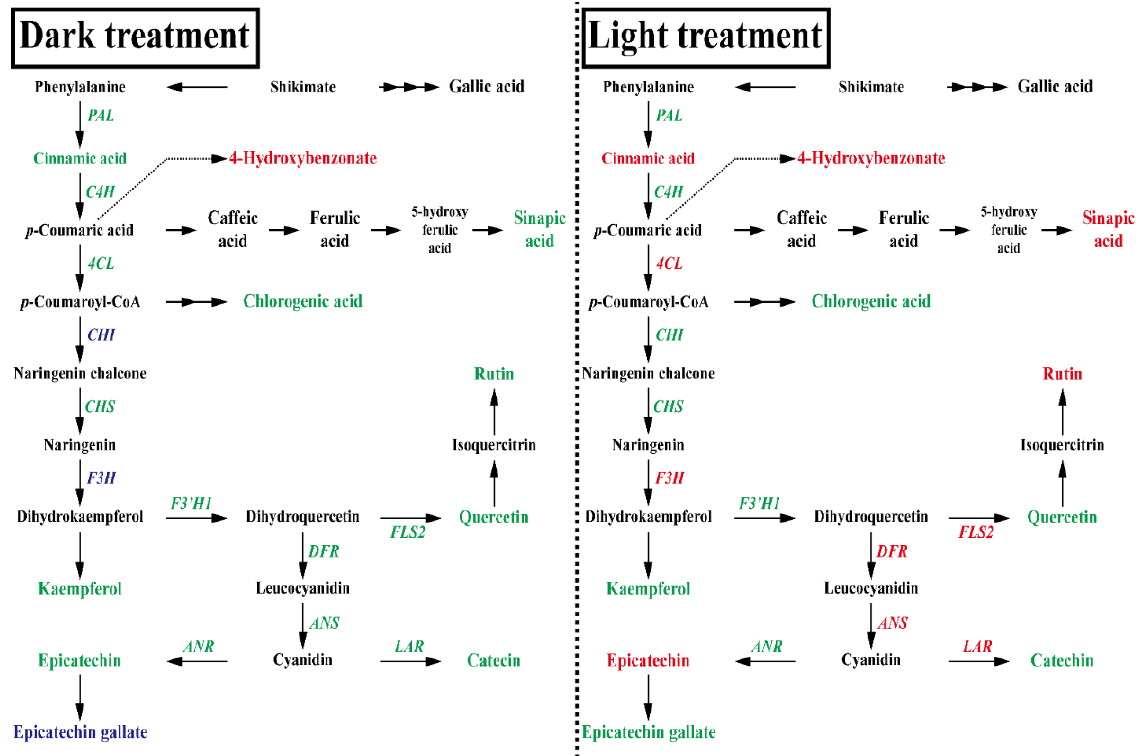
Figure 1. Proposed biosynthetic pathways for phenylpropanoid and flavonoids in Tartary Buckwheat hairy roots overex- pressing ZmLC after dark and light treatment, respectively. Italicized red and blue text indicate significantly upregulated and downregulated genes, respectively ( p < 0.05), after dark and light treatment, respectively, whereas the italicized green text indicates genes that failed to show any significant differences. Red and blue text indicate a significant decrease and increase in phenolic compounds, respectively ( p < 0.05), after dark and light treatment, respectively, whereas the green text indicates phenolic compounds that failed to show any significant differences.